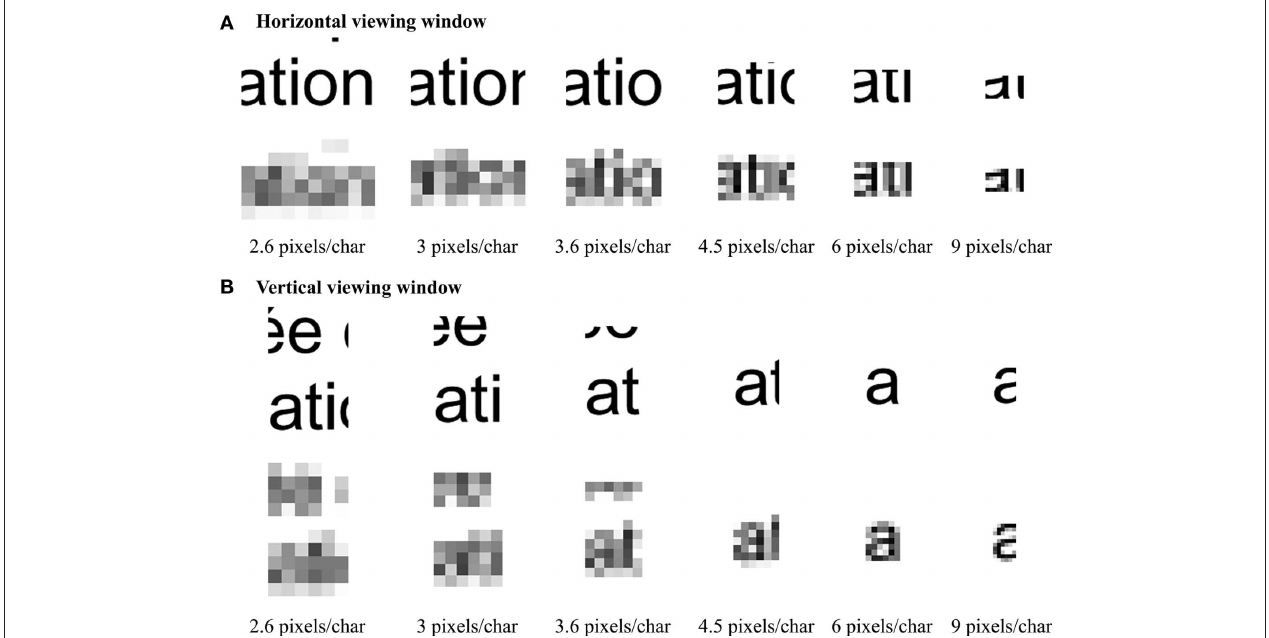
Figure 2 | examples of text portions presented in the viewing window at different spatial resolutions. All viewing windows contain 60 pixels: (A) 10 × 6 pixels (horizontal viewing window), (B) 6 × 10 pixels (vertical viewing window). The spatial resolutions are indicated below each stimulus.